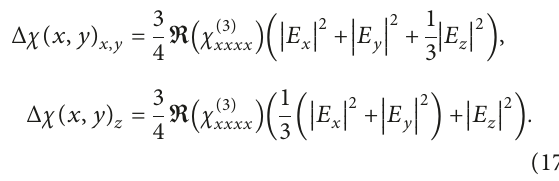
Figure 5: Effective refractive index n a function of the input optical power. The dashed line is the n given by the HFHE formulation, whereas the dots represent the results calculated by a full-vectorial iterative approach (FVI)